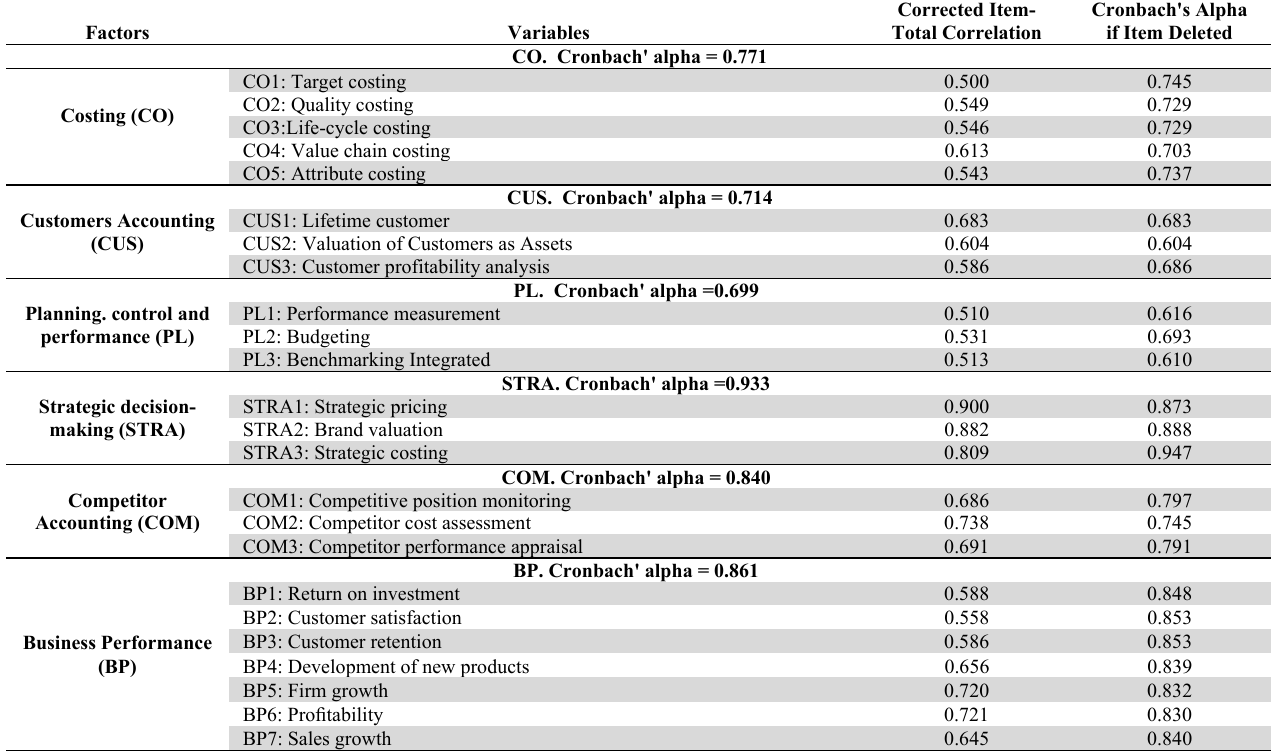
Scale Reliability Test Results